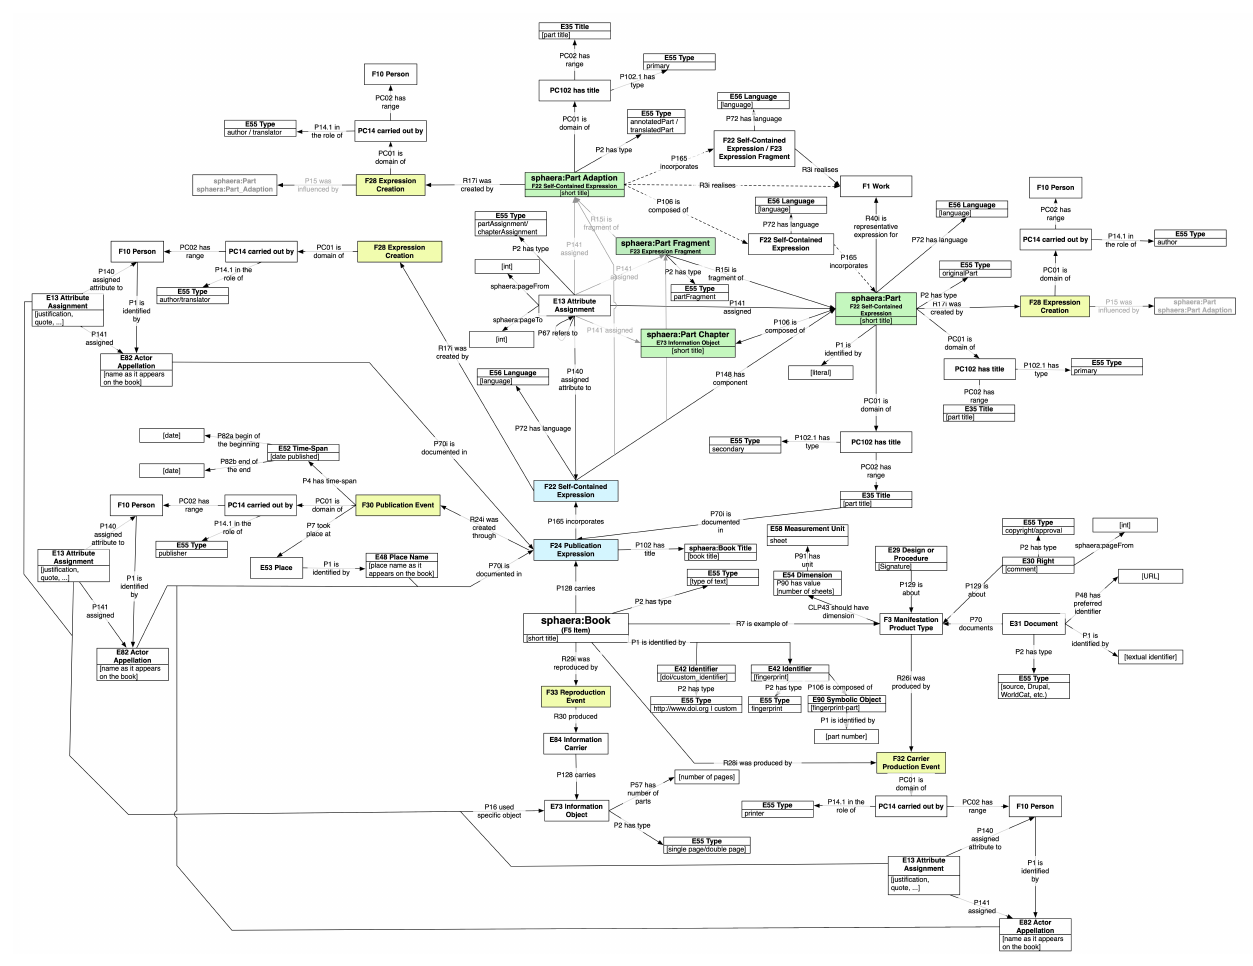
Figure 1. Sphaera CIDOC-CRM data model.